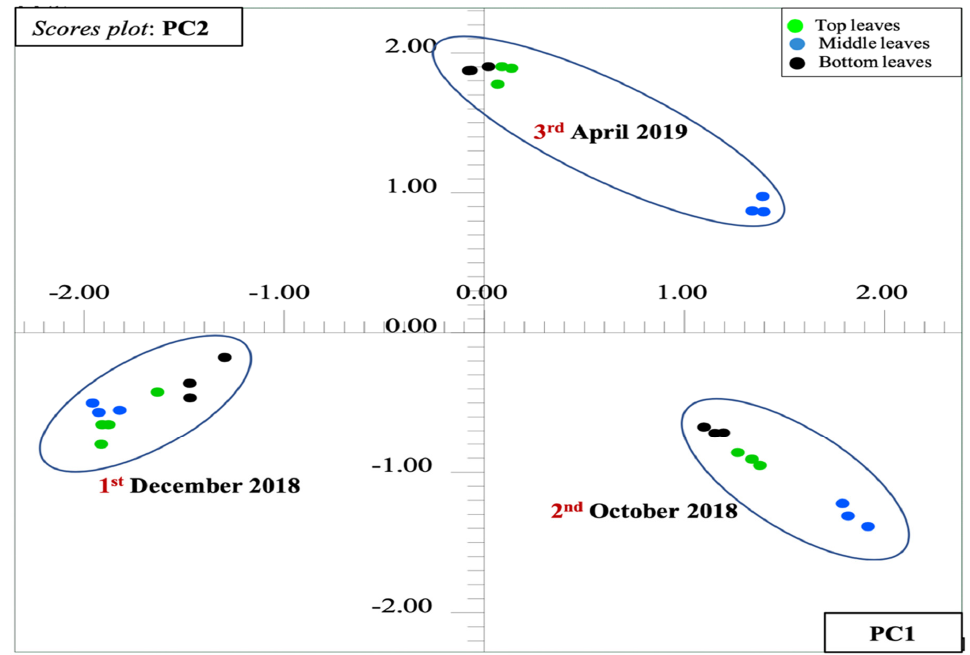
Figure 11. Scores plot from the principle component analysis (PCA) performed over 1 H HR-MAS NMR spectra ( δ 10.0–0.60, 0.04-ppm bucket size, and pareto-scaled) acquired directly from the leaves of Berberis laurina showing discrimination according to the season time. PC1 (50.25%) vs. PC2 (32.09%) of the 28 × 174 data matrix that revealed a net variance of 82.34%. Molecules 2020 , 25 , x FOR PEER REVIEW